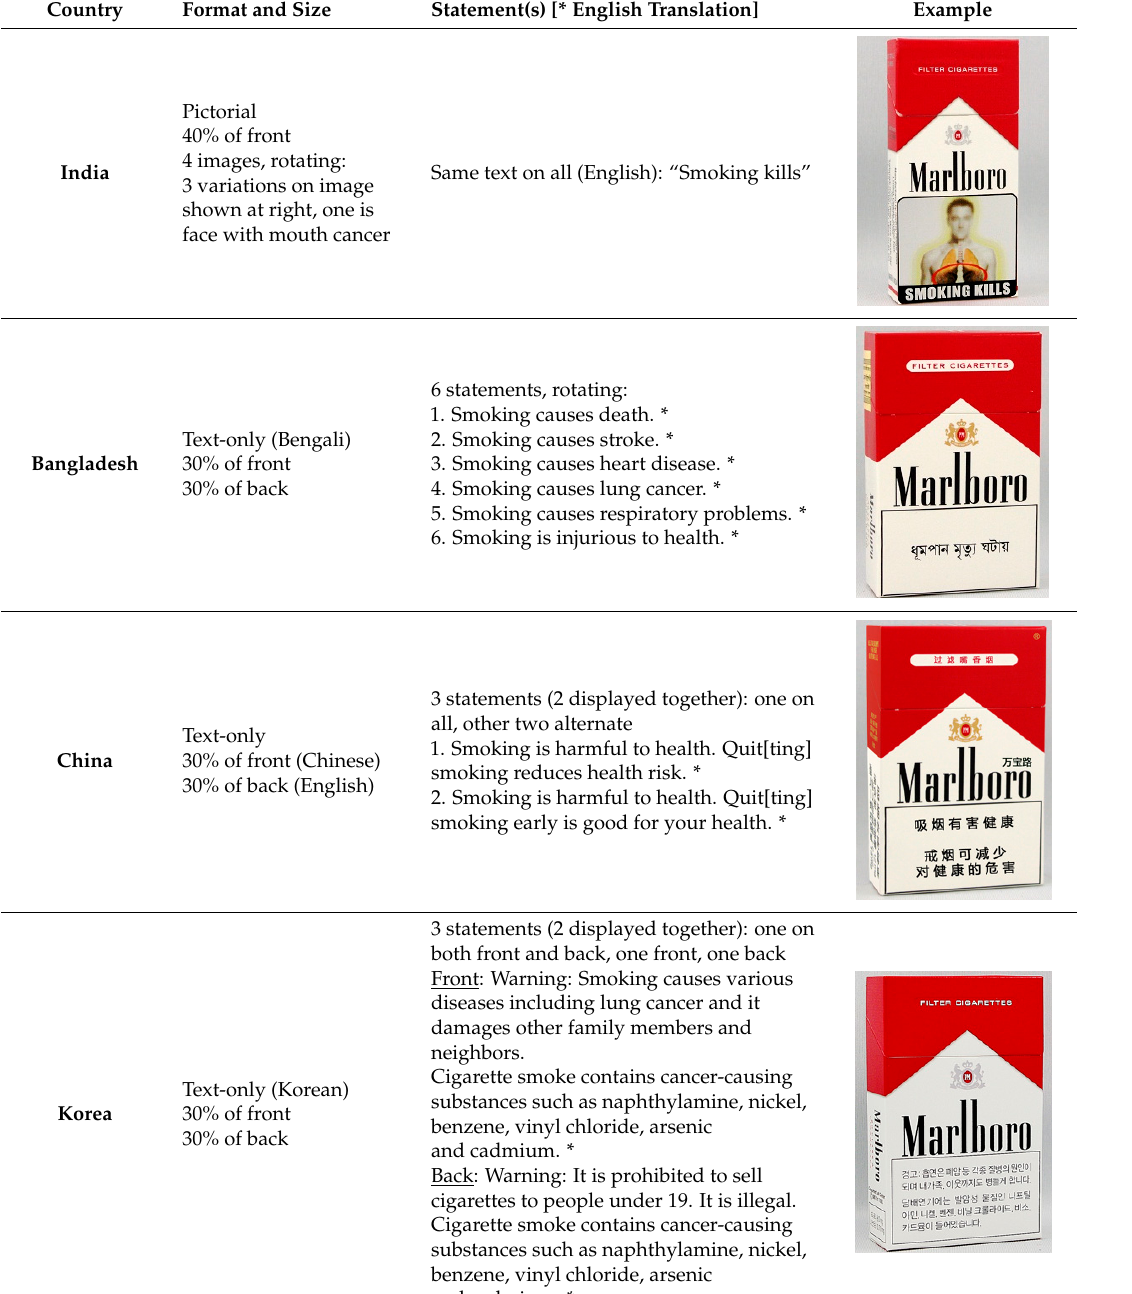
shown at right, one is face with mouth cancer